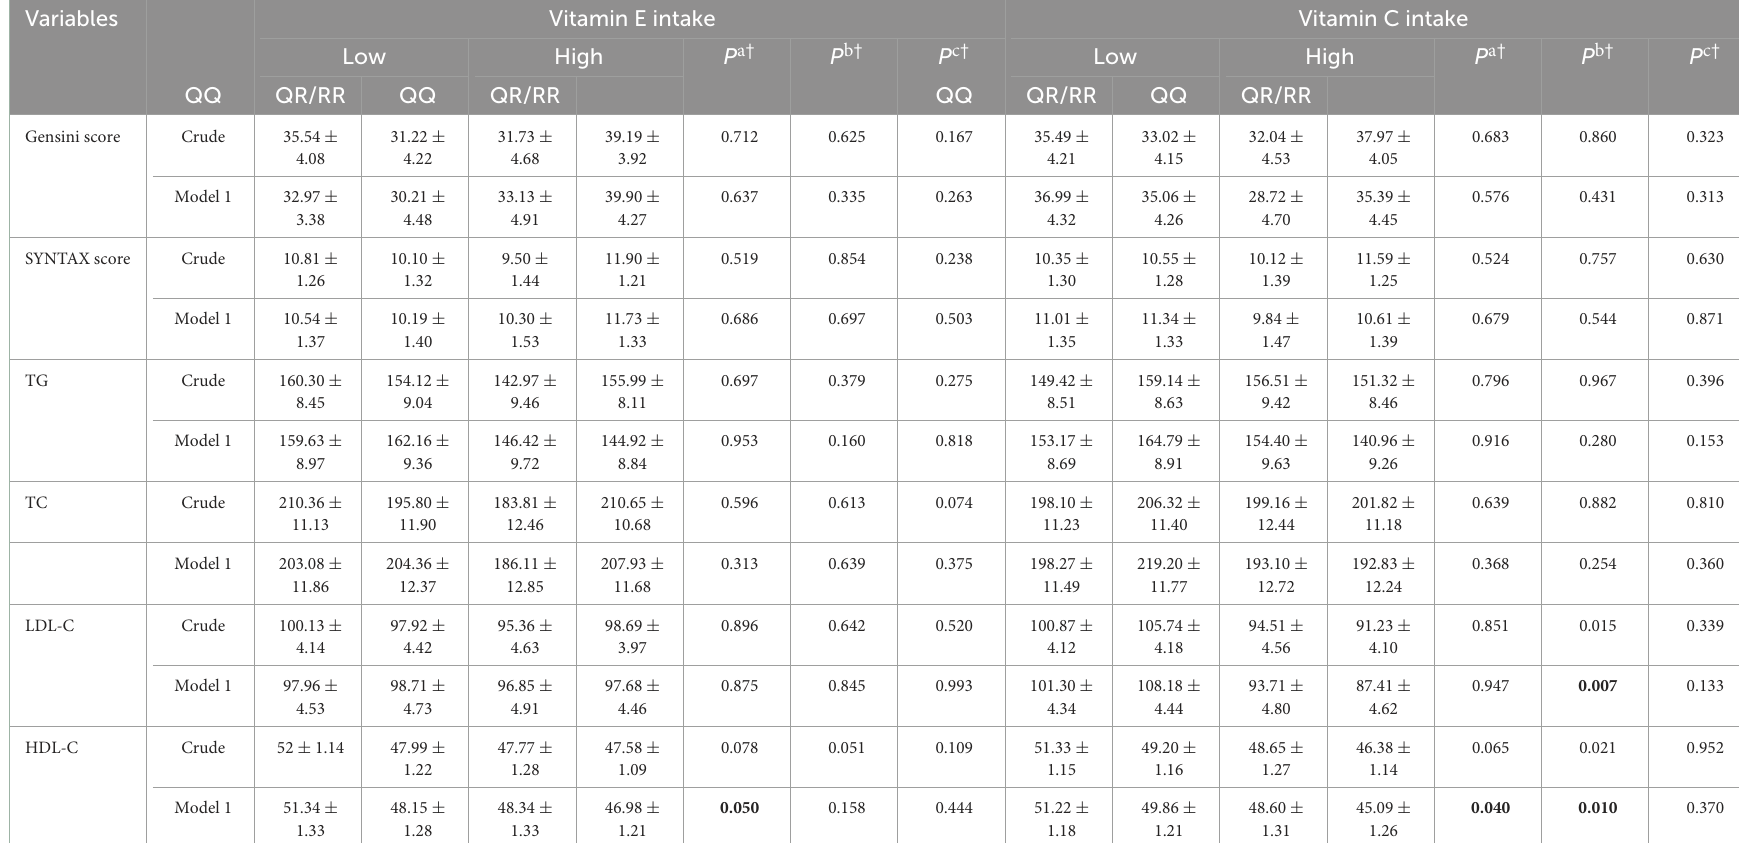
TABLE 2 Mean values of CAD risk factors across PON1 genotypes (QQ and QR + RR) based on two categories of vitamin E and C intake.